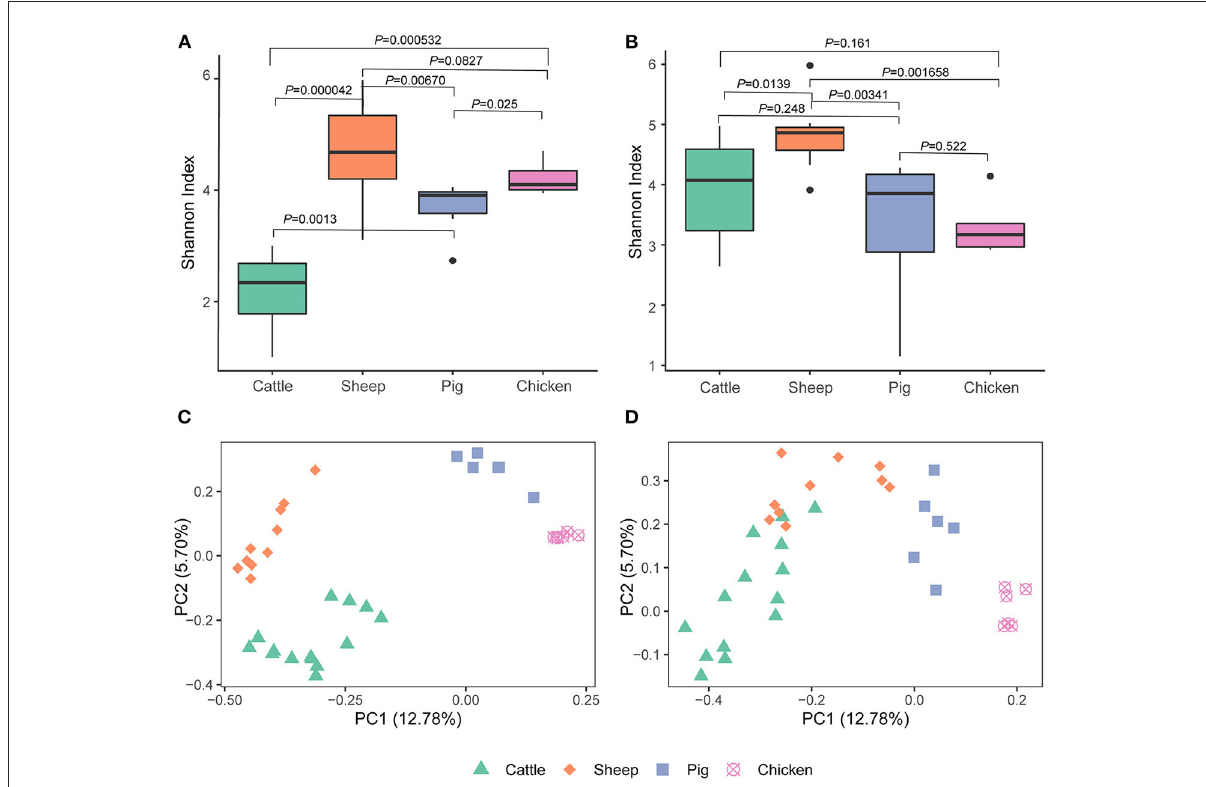
FIGURE1 Alpha [Shannon index, (A,B) ] and beta [Bray-Curtis, (C,D) ] diversity of gut archaea based on the metagenome (A,C) and metatranscriptome (B,D) .